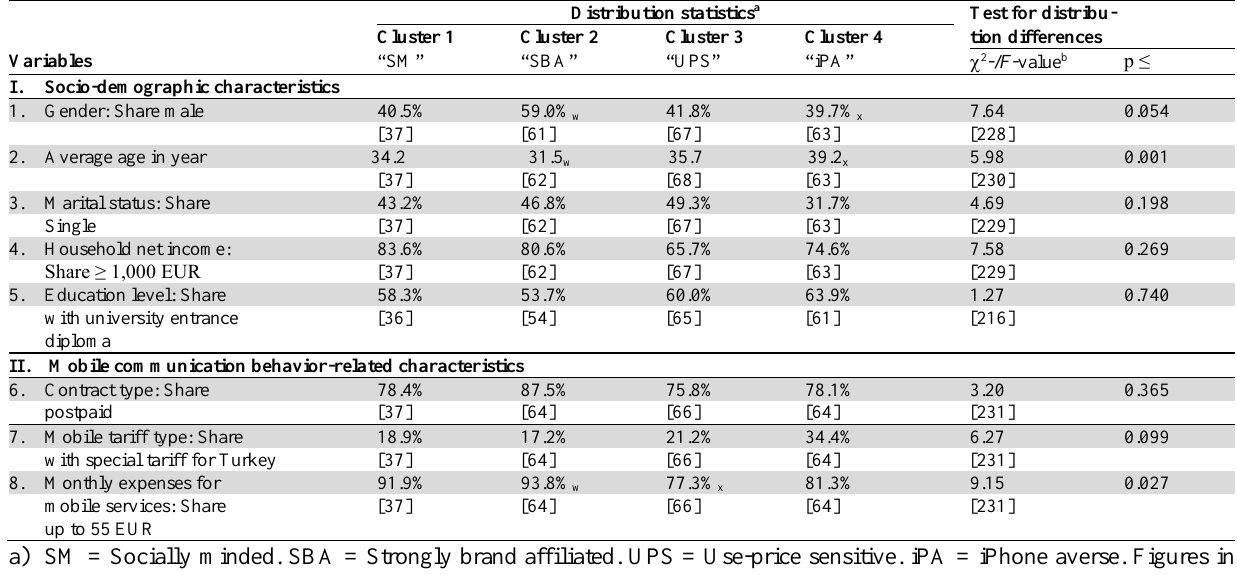
Comparisons of socio-demographic and mobile service consumption behavior-related variables across the four clusters Distribution statistics a Test for distribu- Cluster 1 Cluster 2 Cluster 3 Cluster 4 tion differences Variables “SM” “SBA” “UPS” “iPA” χ 2 -/ F -value b p ≤ I. Socio-demographic characteristics 1. Gender: Share male